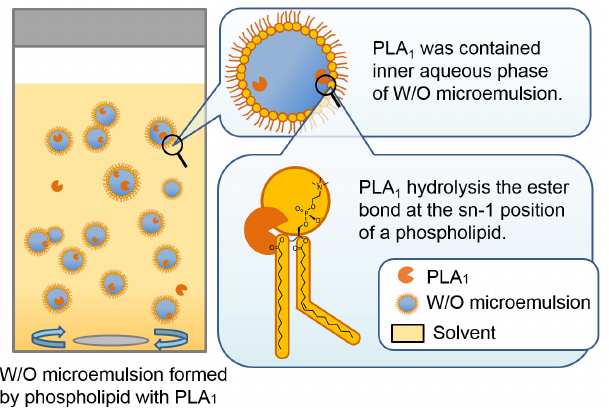
Figure 1. Schematic illustration of hydrolysis reaction in water-in-oil (W/O) microemulsion of non-immobilized phospholipase A 1 (PLA 1 ).